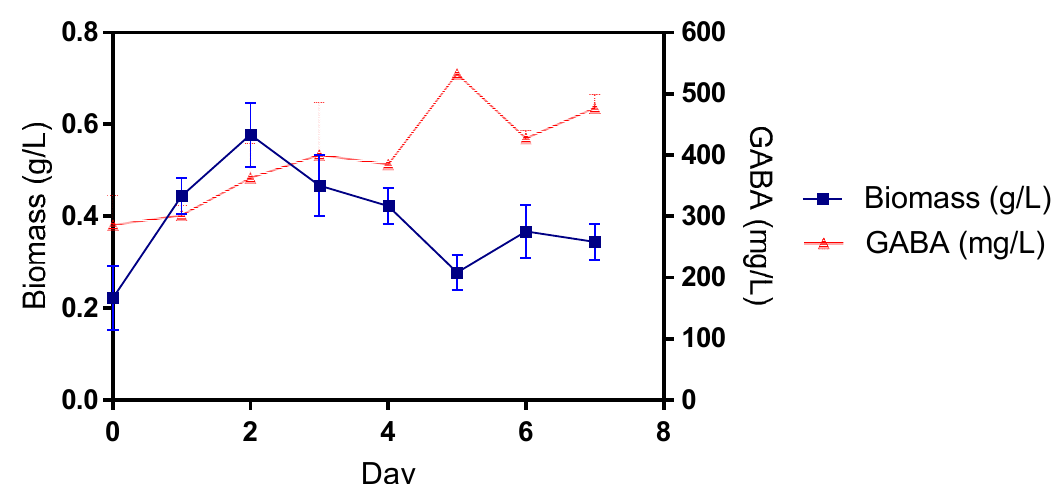
Figure 3. Biomass and GABA production of Bacillus cereus strain KBC in a 7-day cultivation period.